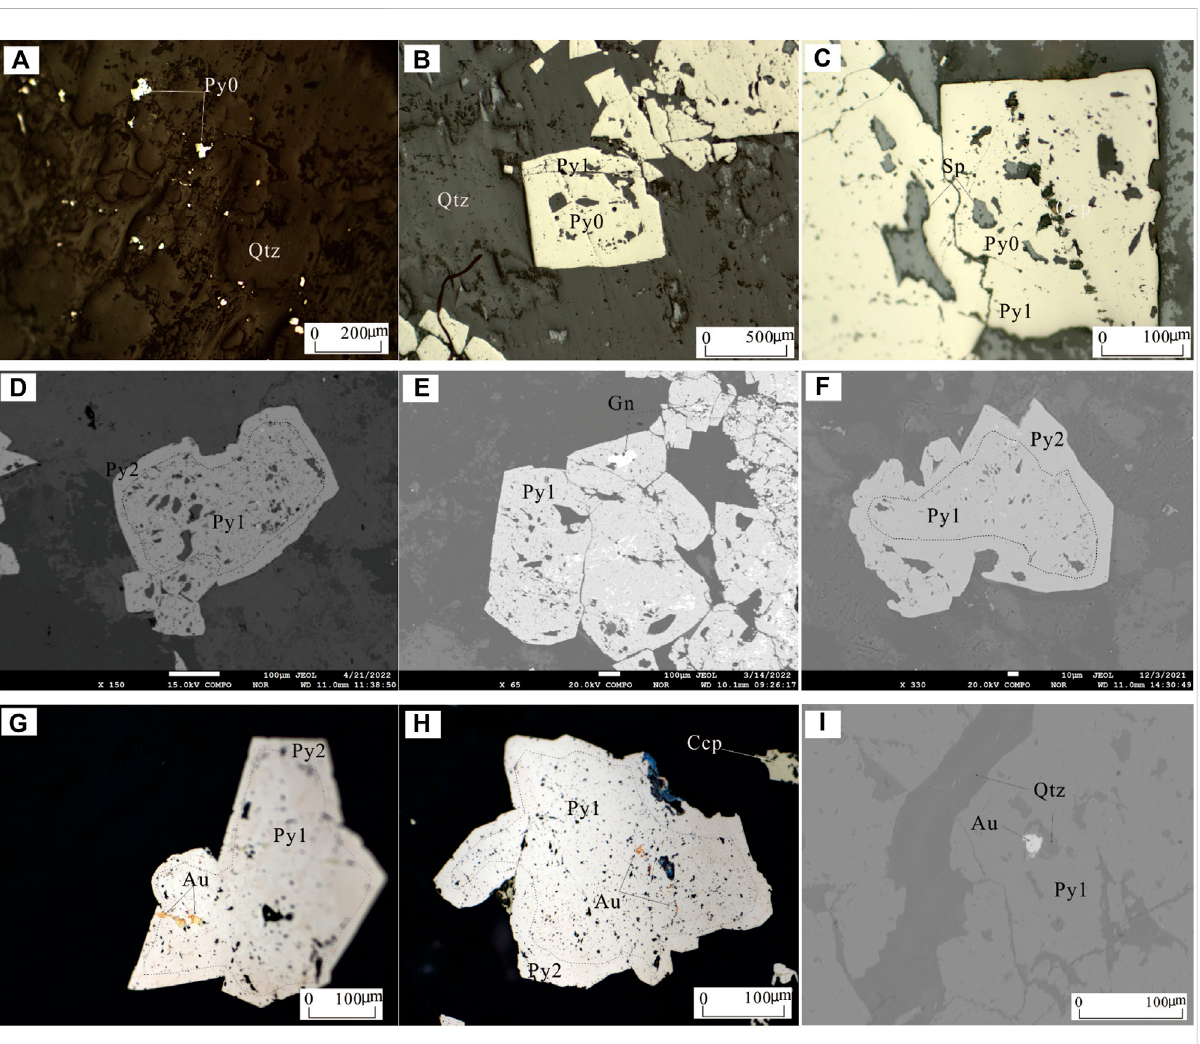
FIGURE 4 Representative re fl ected-photomicrographs (A – C) and backscattered electron (BSE) images. (D – I) Occurrences of visible gold and textural features of pyrite.